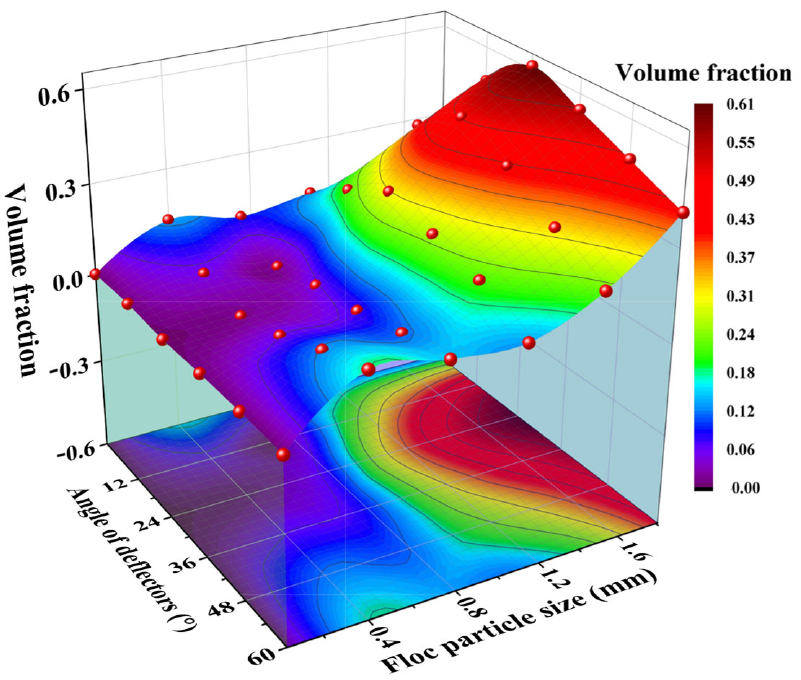
Figure 15. Variation in the volume fraction of flocs at each scale in the flow field of the feedwell according to the angle α of the deflector plate.